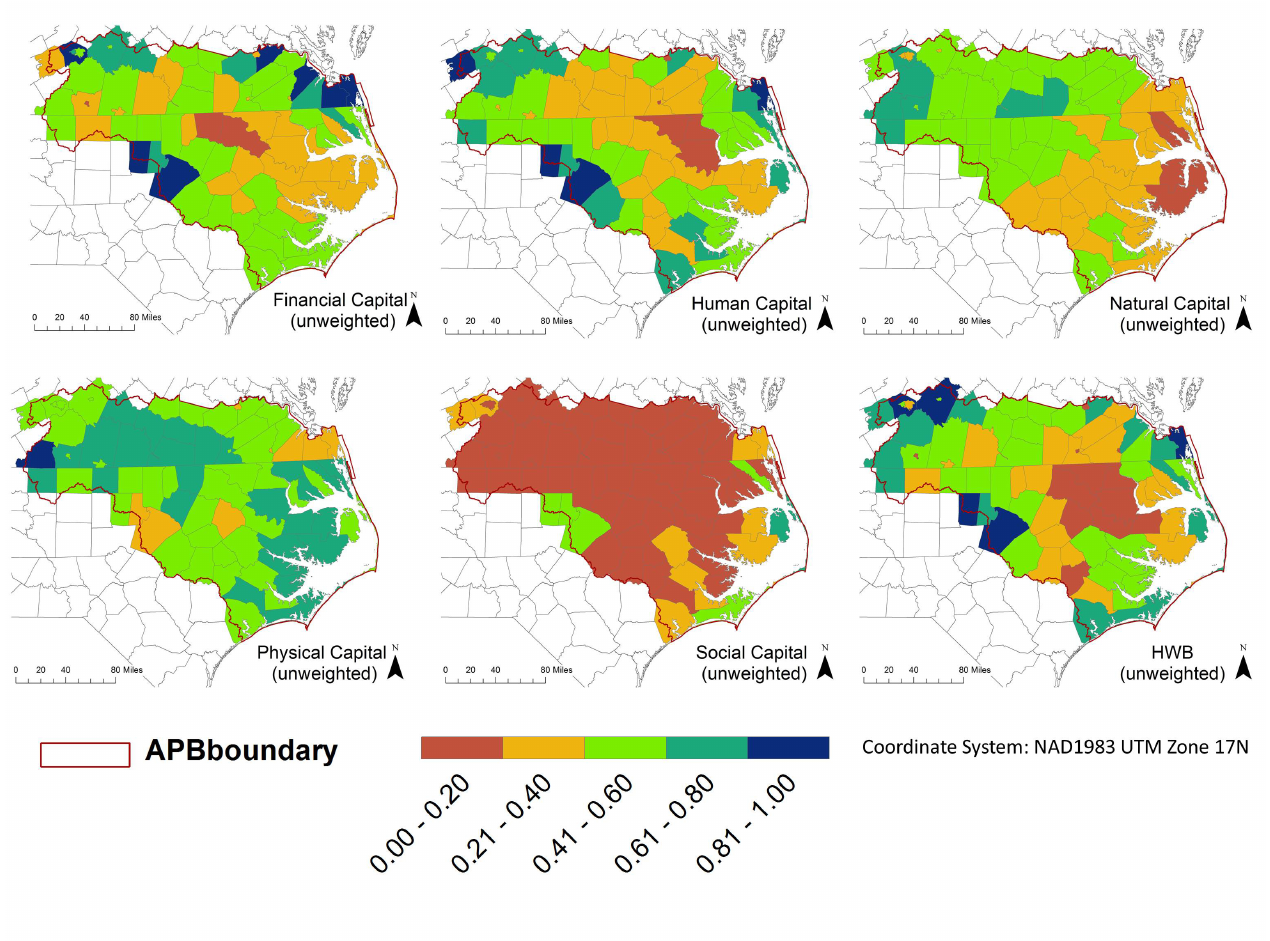
Fig. 2 . Capital asset conditions equally-weighted. Top (left to right): Financial, Human, Natural; Bottom (left to right): Physical, Social, and the composite measure of HWB based on equally weighted capitals and